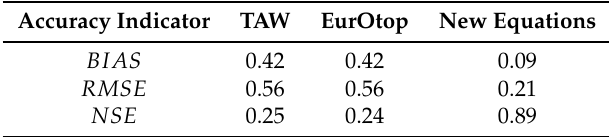
Table 2. Accuracy measures of estimates given by new equations and existing methods for data sets R1, R2, R3 and